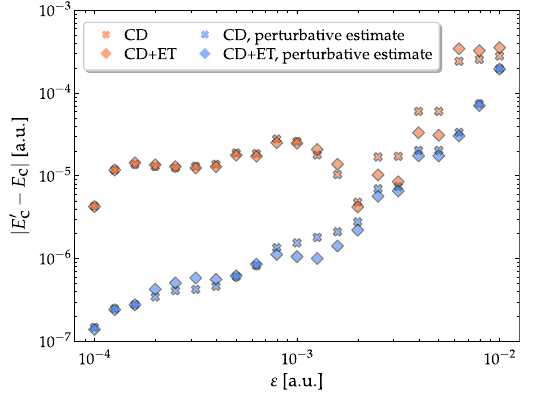
Fig. 2 Error j E 0 c (cid:2) E c j for H 2 O (cc-pVDZ) as a function of ε = ε TH = ε CD , with and without perturbative correction (blue, orange points respectively) for CD and CD + ET truncation schemes (crosses, diamonds), measured using HF and CC wavefunctions. The error increases with ε , and is visibly smaller with perturbative